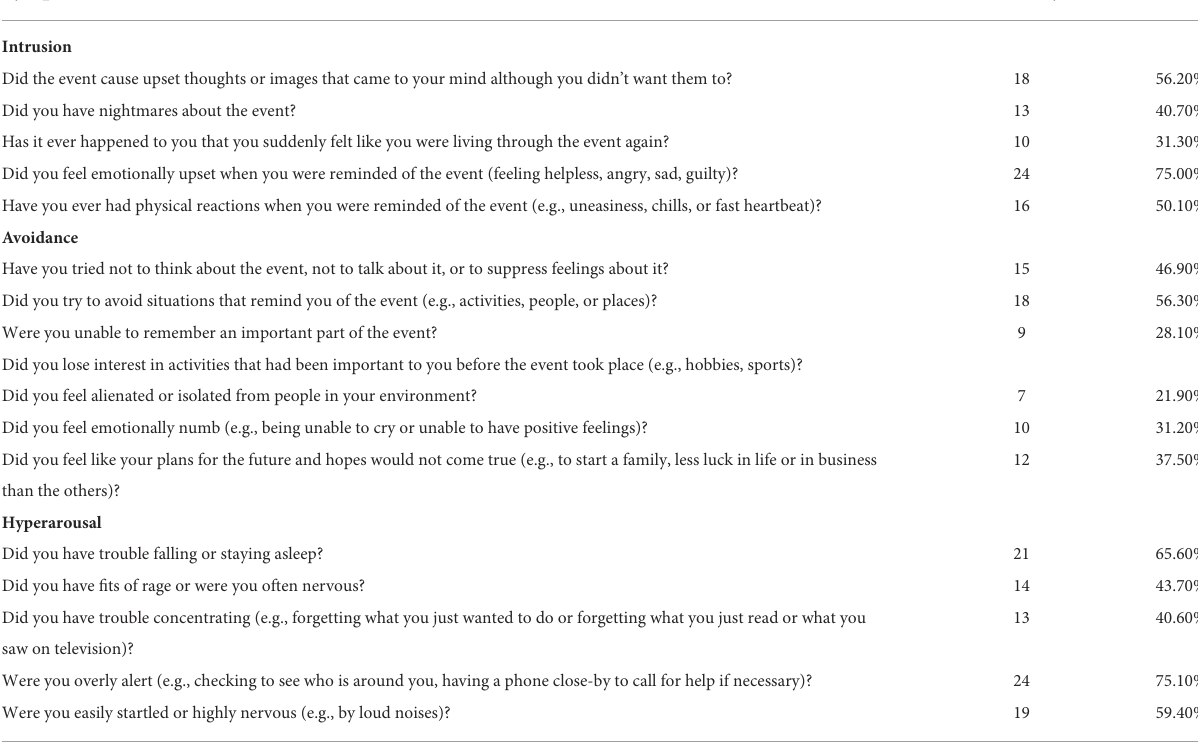
TABLE 5 PTSD symptoms of rural residents who survived the tornado disaster.